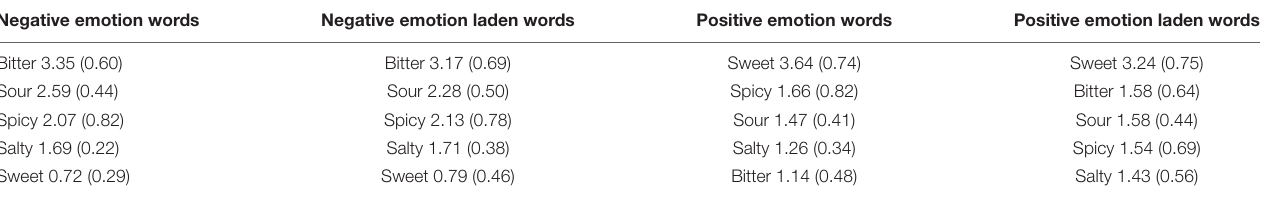
TABLE 4A | Means and standard deviation of each taste for the four kinds of emotional words (sorted in descending order by means). Negative emotion words